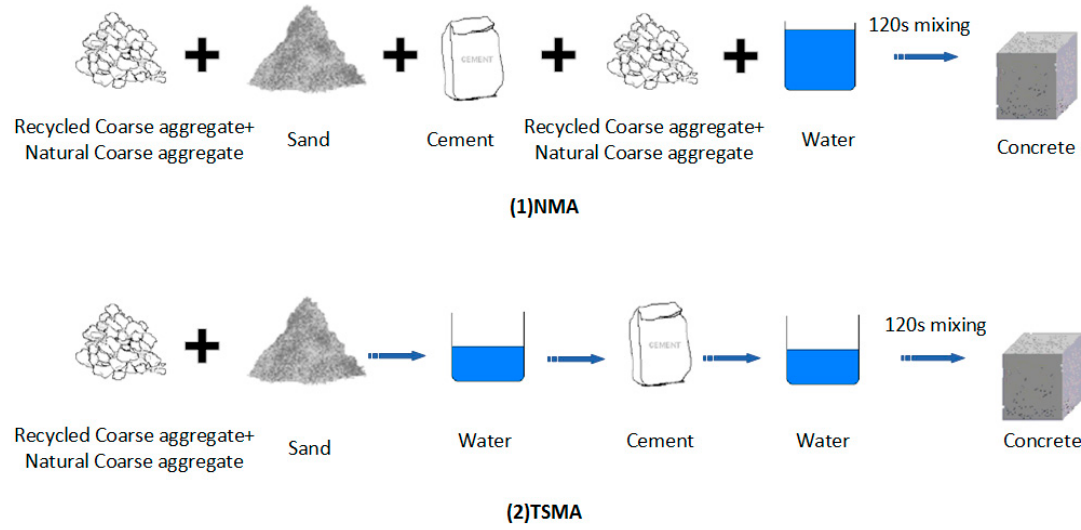
Figure 5. The mixing process of all components.